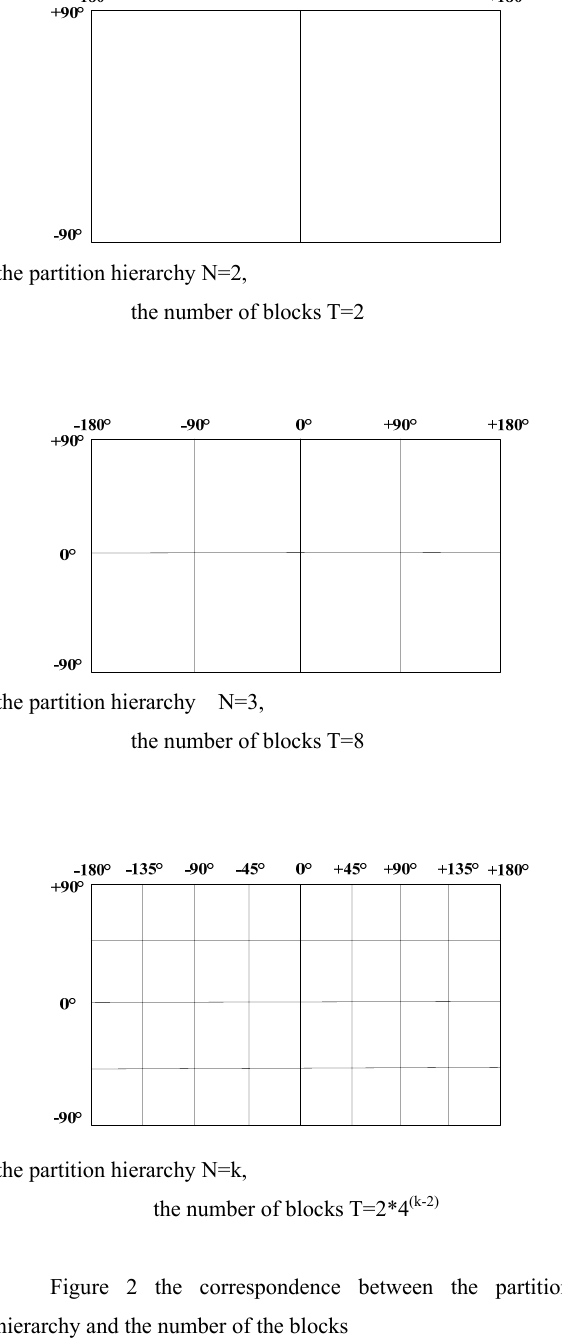
Figure 2 the correspondence between the partition hierarchy and the number of the blocks